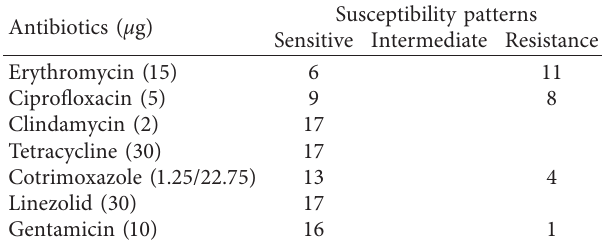
Table 3: Antibiotic susceptibility pattern of MSSA.